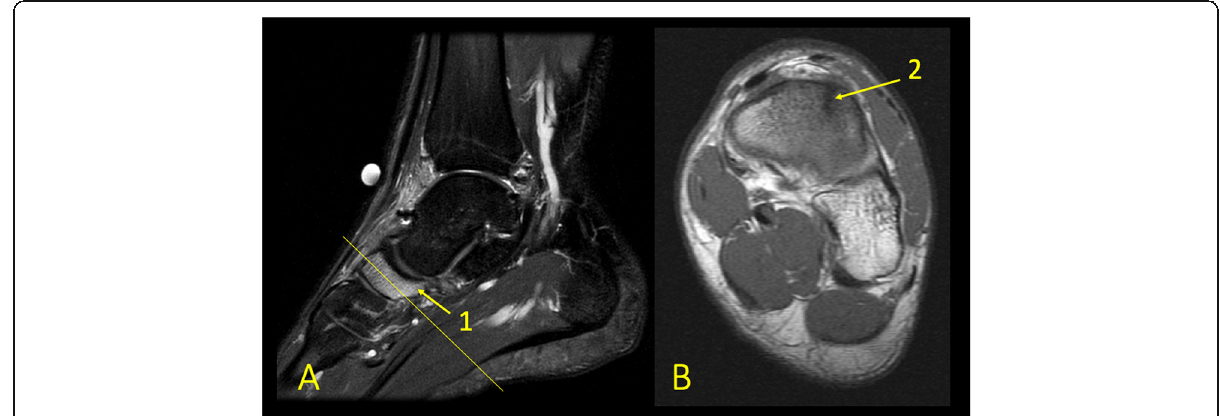
Fig. 14 An 18-year-old female with diffuse pain at the level of the navicular bone. MRI with ( a ) T2-weighted fat suppression and ( b ) T1-weighted coronal images revealed extensive BME (1) and a stress fracture in the navicular bone